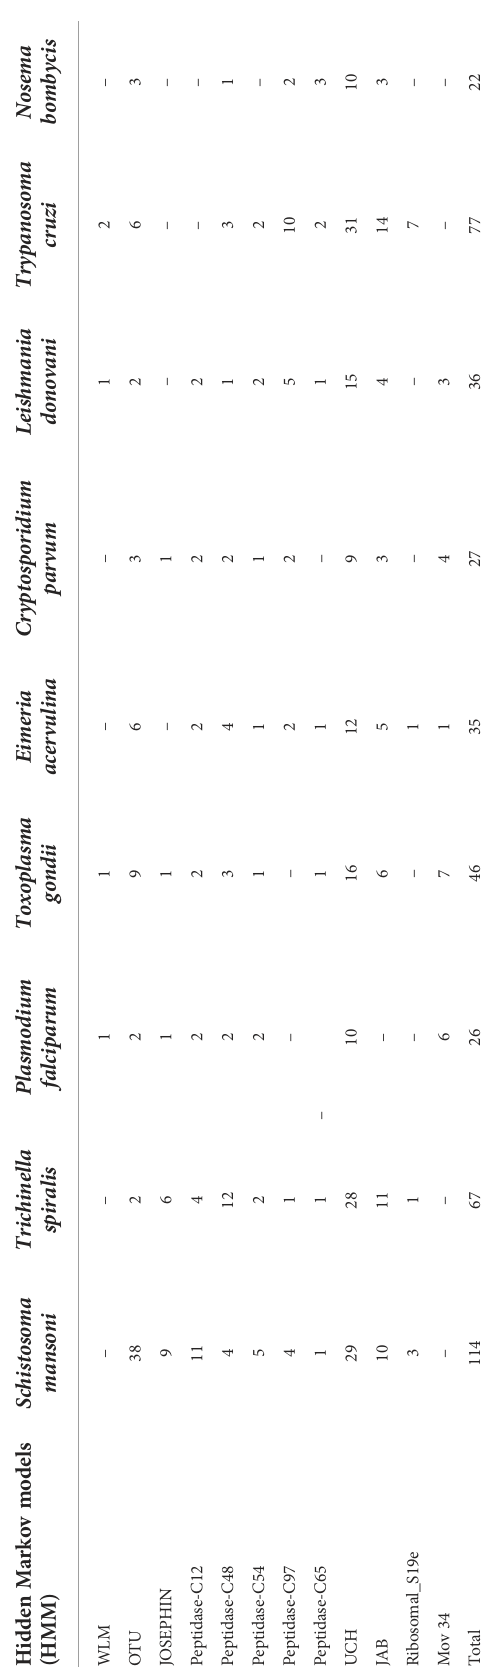
and 44.65% identity). However, parasites such as T. cruzi , C.